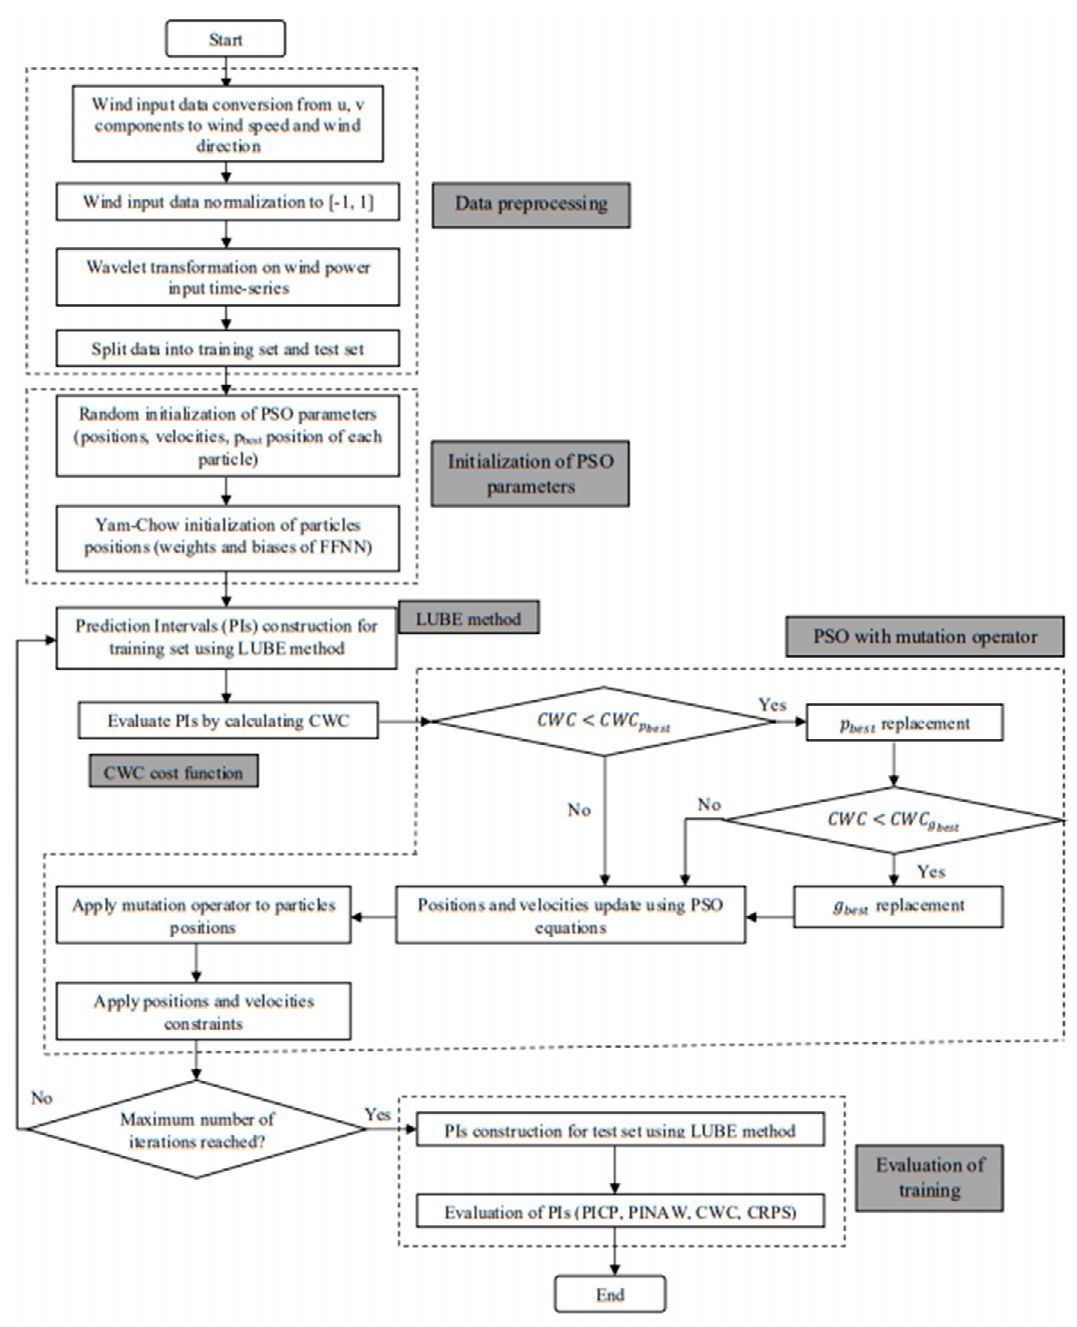
Figure 7. Complete flow chart of the proposed WT-LUBE-PSO-CWC methodology.